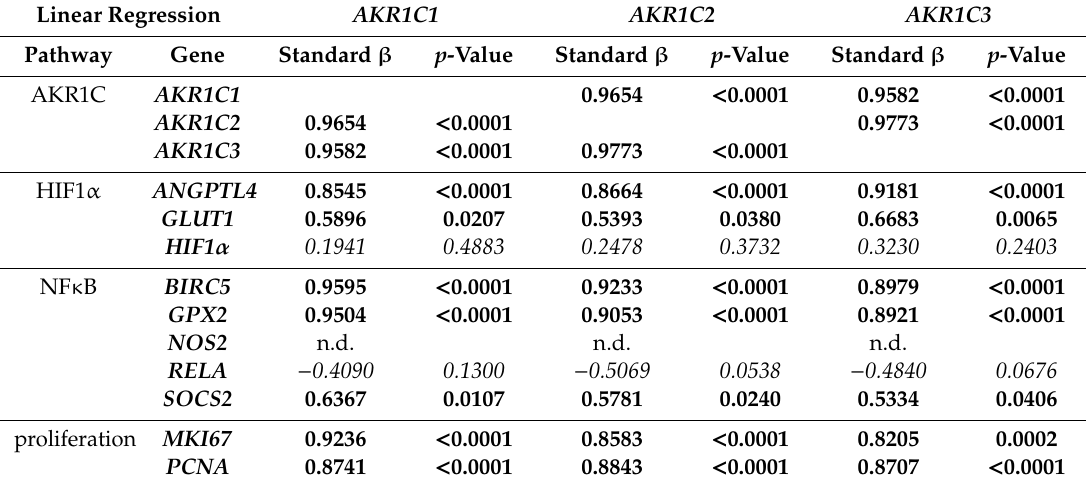
Table 2. The gene expression levels of AKR1C1, AKR1C2, and AKR1C3 were related to the genes indicated using multiple linear regression models in 5.5, 11.25, and 17.5 mM glucose-treated PC3 cells ( n = 15). Standard β values represent standardized regression coe ffi cients. Significant gene associations are indicated in bold lettering, nonsignificant gene associations in italics. Statistical significance was considered as p < 0.05. n.d.; mRNA level of NOS2 was not consistently detected in PC3 cells.